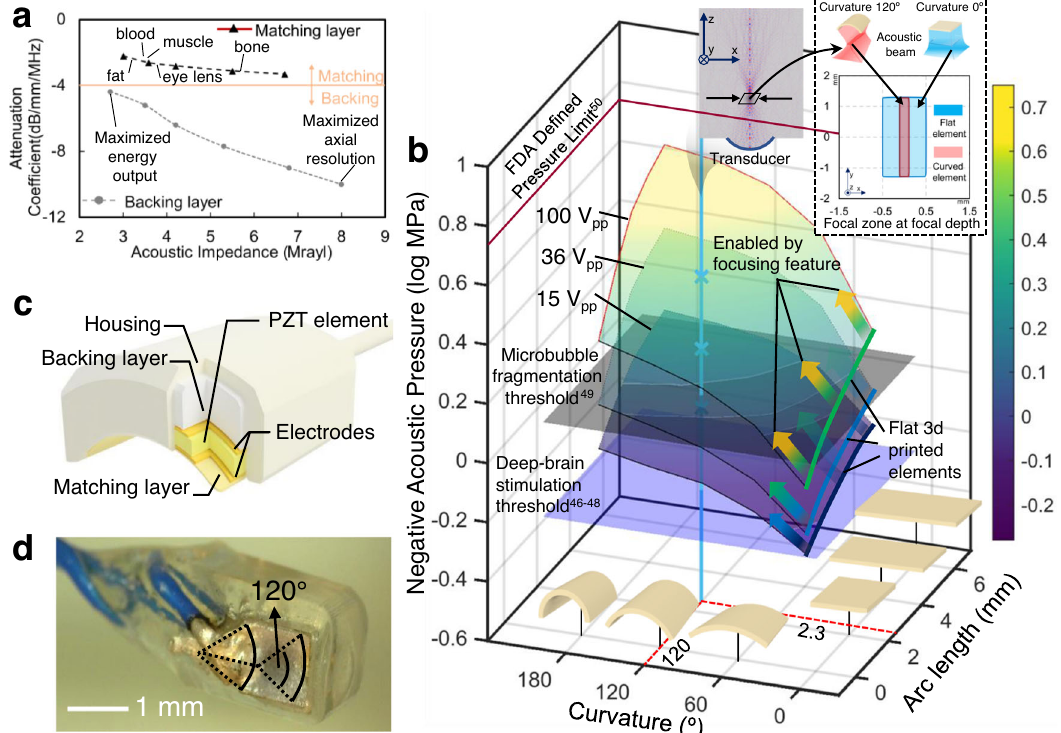
Fig. 3 | Packaging design and acoustic energy output performance of the as- fabricated miniaturized ultrasound transducer. a 3D printable materials with tunable attenuation coef fi cient and acoustic impedance for transducer packaging. b Acoustic pressuremap vs. 3D printed miniaturized transducer curvatureand arc